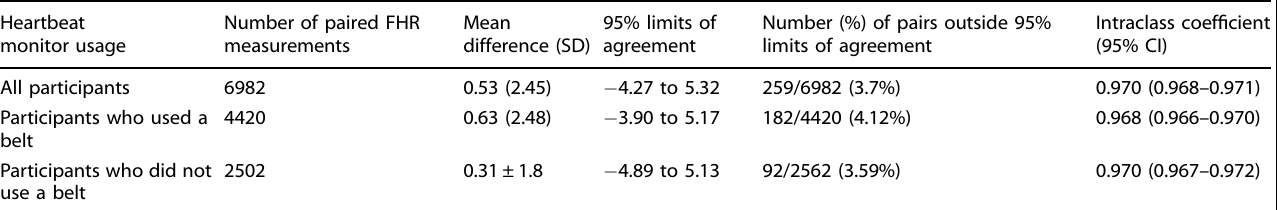
Table 2. Fetal heart rate agreement between heartbeat monitor and cardiotocography for all paired time points, and for participants who used and did not use a stability belt. All measures in beats per minute.